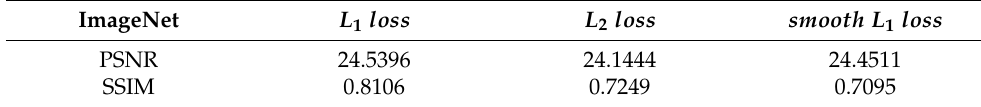
Table 10. Results of different loss functions under the ImageNet dataset.